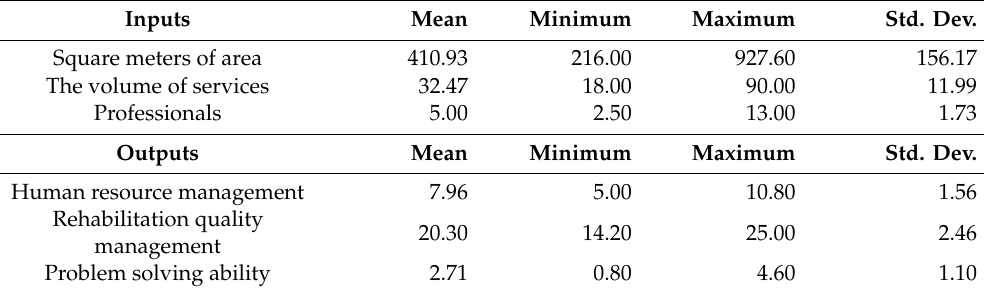
Table 2. Descriptive statistics of the case